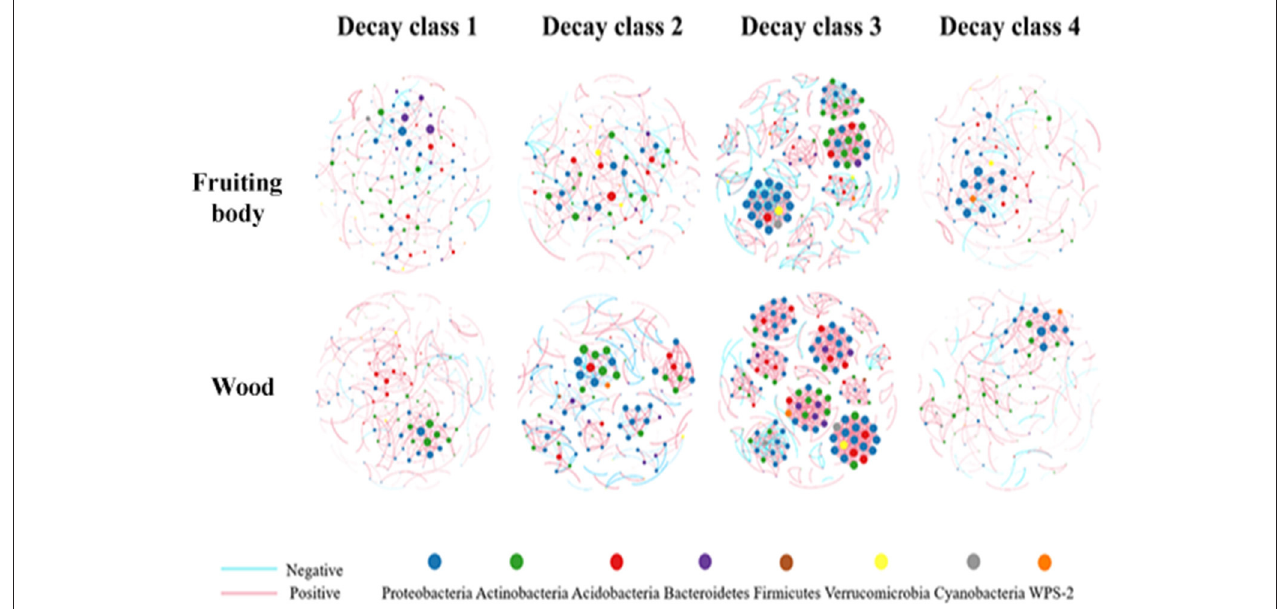
FIGURE 7 | Co-occurrence networks of top 252 OTUs showing the significant correlations in fruiting body and wood over decay. Nodes represent individual OTUs; edges represent significant Spearman correlations ( ρ > 0.7, P < 0.001). The size of node represents its link degree, the larger node has more connections with other nodes. The thickness of edge represents the correlation level. The red and blue edges show the positive and negative connections between nodes